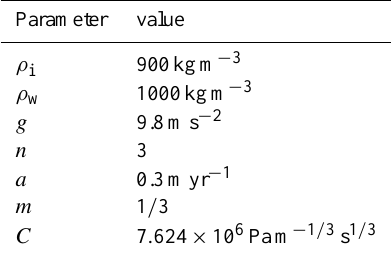
Table 4. List of parameter values. With the chosen value of C , a basal shear stress of 80kPa corresponds to a sliding velocity of about 35ma − 1 .